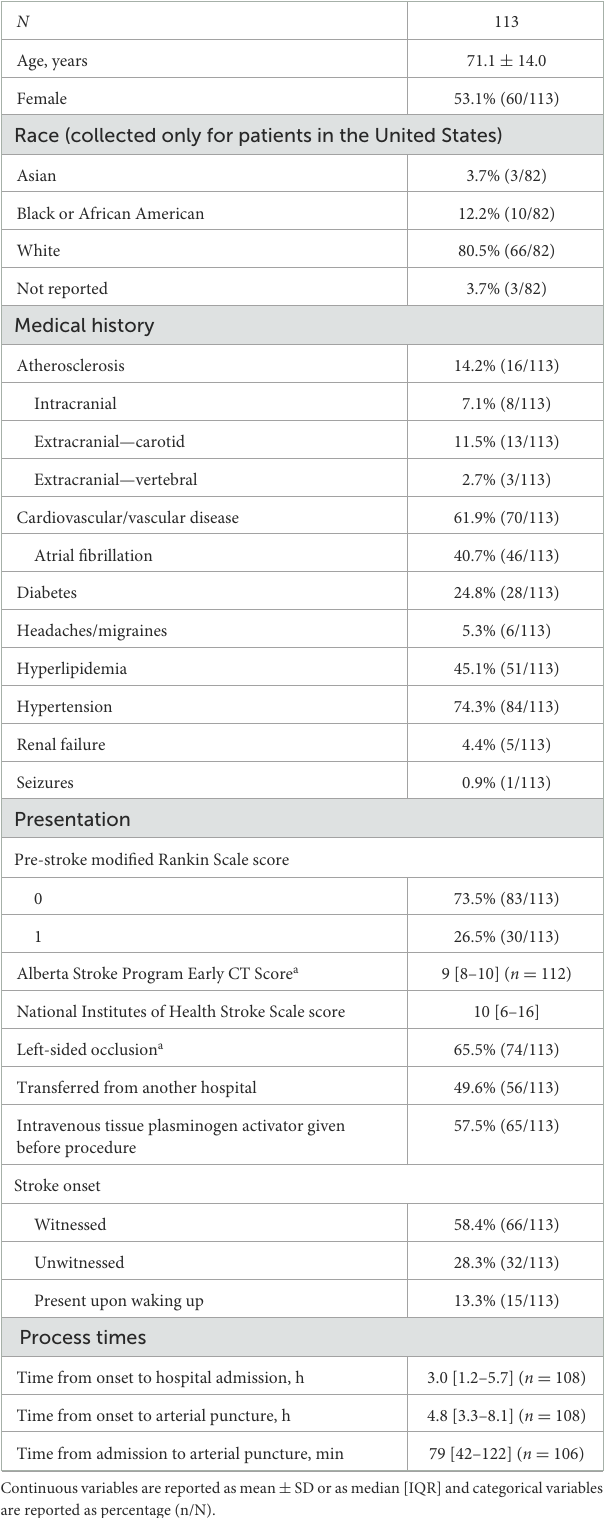
TABLE 1 Baseline characteristics of patients treated with aspiration thrombectomy for acute ischemic stroke due to M2 middle cerebral artery